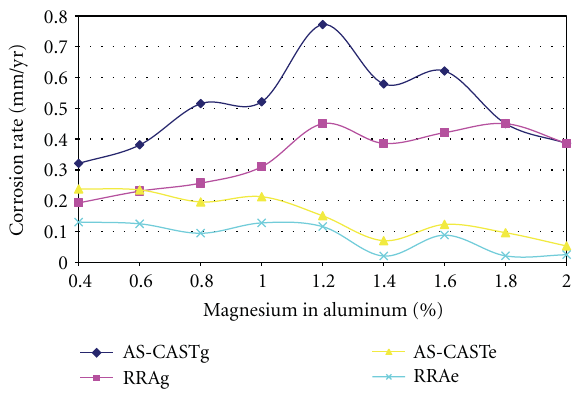
Figure 5: E ff ect of magnesium addition on the corrosion resistance of aluminum alloy in EXCO solution. Note : RRAg and AS-CASTg curves indicate the corrosion responses of heat-treated and as-cast Al-Mg alloy specimens, respectively, in EXCO solution as evaluated through the gravimetric technique while RRAe and AS-CASTe curves illustrate the corrosion behaviors of heat-treated and as-cast Al-Mg alloy specimens, respectively, in EXCO solution as evaluated through the electrochemical polarization